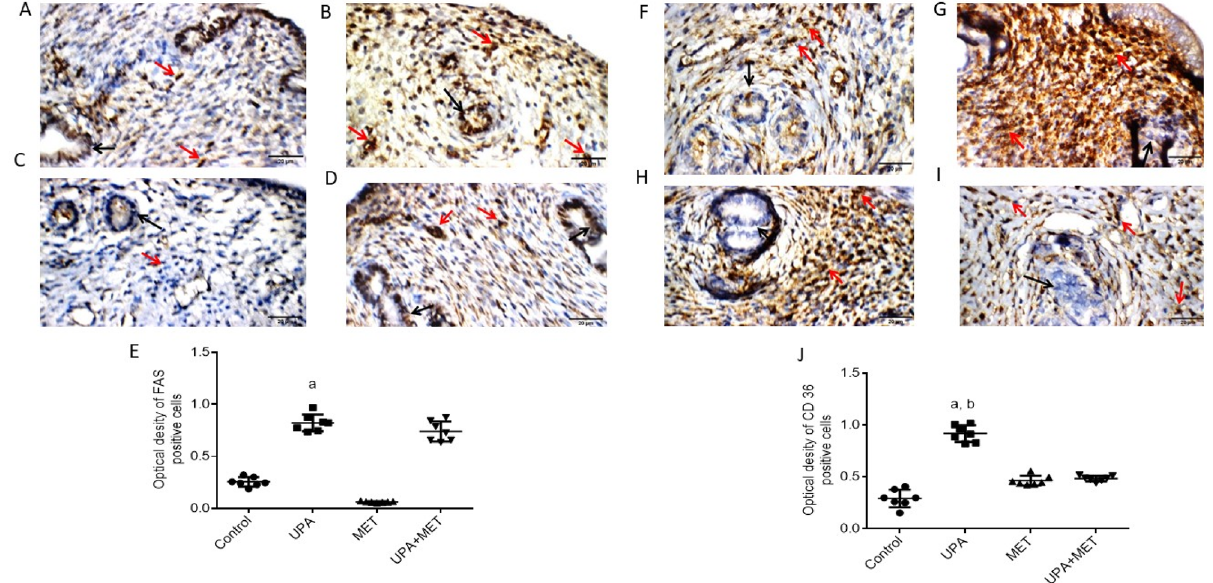
Figure 7. Effect of ulipristal and/or metformin on the expression of proteins involved in lipid metabolism in rats’ uteri. ( A – D ) Photomicrographs of uteri shows expression of FAS. ( A ) Uterine wall in the control group. ( B ) Uterine wall in ulipristal treated group. ( C ) Uterine wall in metformin treated group. ( D ) Uterine wall in the ulipristal and metformin treated group. × 400 magnification (scale bar = 20 μm). ( E ) Expression quantification of the optical density reactivity of positive cells of FAS by the ImageJ analysis system. ( F – I ) Photomicrographs of uteri shows expression of CD 36. ( F ) Uterine wall in the control group. ( G ) Uterine wall in ulipristal treated group. (H) Uterine wall in metformin treated group. ( I ) Uterine wall in the ulipristal and metformin treated group. × 400 magnification (scale bar = 20 μm). ( J ) Expression quantification of the optical density reactivity of positive cells of CD 36 by the ImageJ analysis system. Data figures ( E ) and ( J ) is represented by mean ± SD (n = 7). a or b, Statistically significant from the control or ulipristal and metformin treated group respectively at P < 0.05 using one-way ANOVA followed by Tukey as a post hoc test. UPA ulipristal, MET metformin, UPA + MET co-treatment with ulipristal and